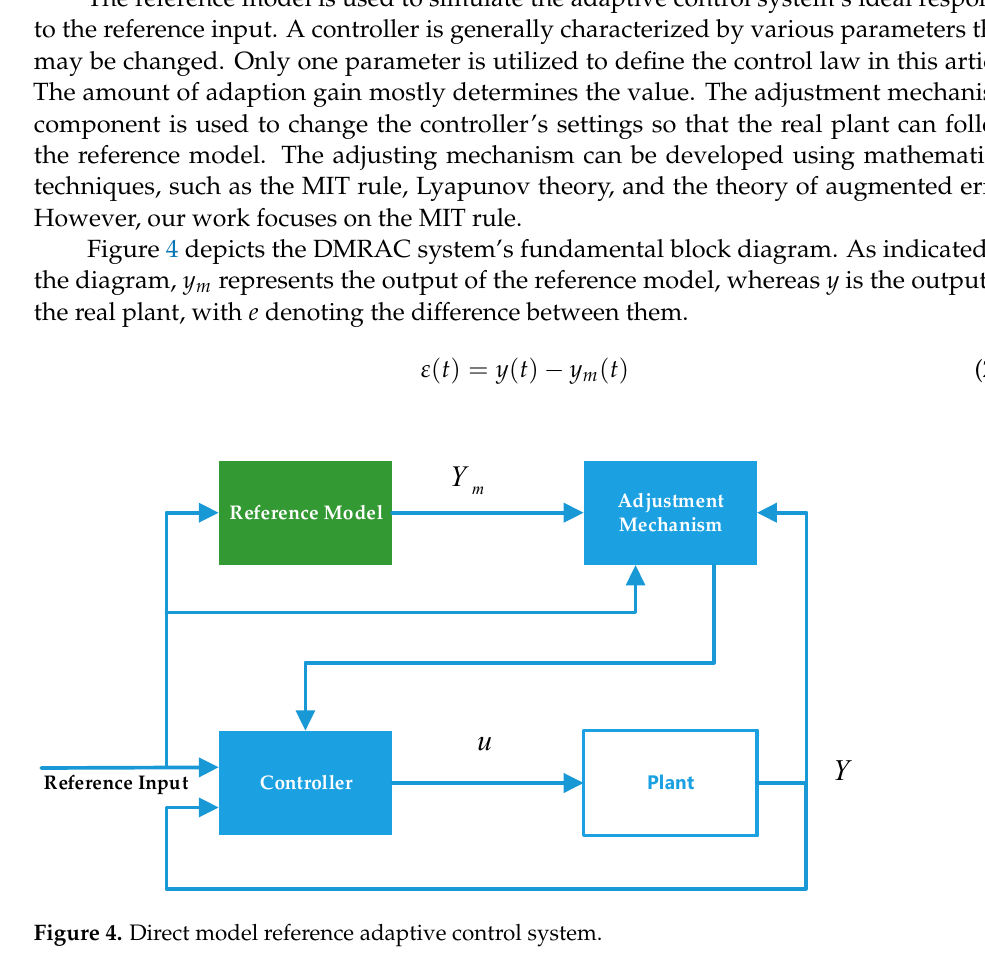
Figure 3. Boost converter considering parasitic components .